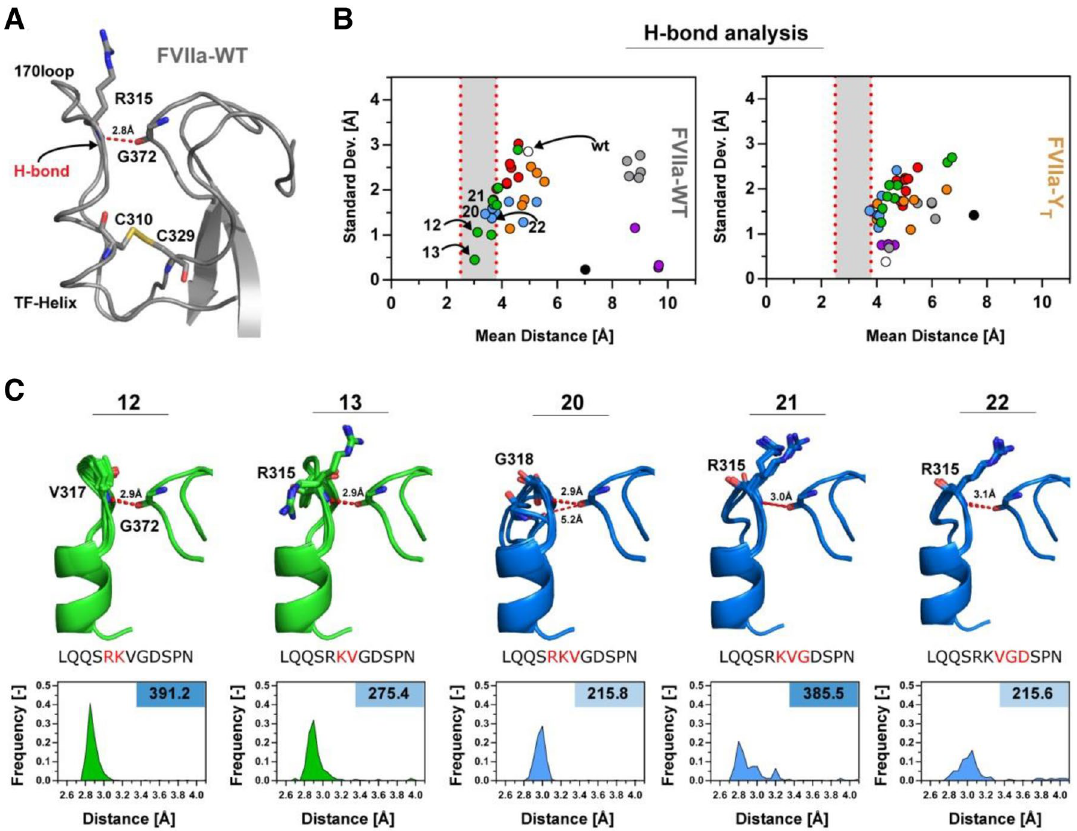
Figure 5. Variants with an Intermediate Loop Length Show TF-Induced-Like Interactions. ( A ) The 170 loop region of FVIIa (PDB ID, 1dan) with the hydrogen bond between R315{c170C} and G372{c223} shown in red, together with the C310{c168}-C329{c182} disulphide-bridge in yellow. ( B ) The mean distance between the residue corresponding to the R315{c170C} backbone nitrogen and G372{c223} oxygen plotted against the standard deviation of the bond length for the FVIIa-WT (left panel) or FVIIa-Y T backbone (right panel). Bond lengths of 2.5–3.8 Å are marked in grey for loop conformations with possible stable hydrogen bonds including variants 12–13 and 20–22. ( C ) Overview of group 1 variants with high activity including 10 modelled structures with the lowest Rosetta Energy (see supplemental Fig. S4) with the average hydrogen-bond distance shown in red. Frequency histograms for variants with distances in the 2.5–4.0 Å range showing a favourable distribution for loop lengths 11–12. The corresponding S-2288 activity relative to FVIIa in the right top-corner and deleted amino acids are coloured in red on the shown